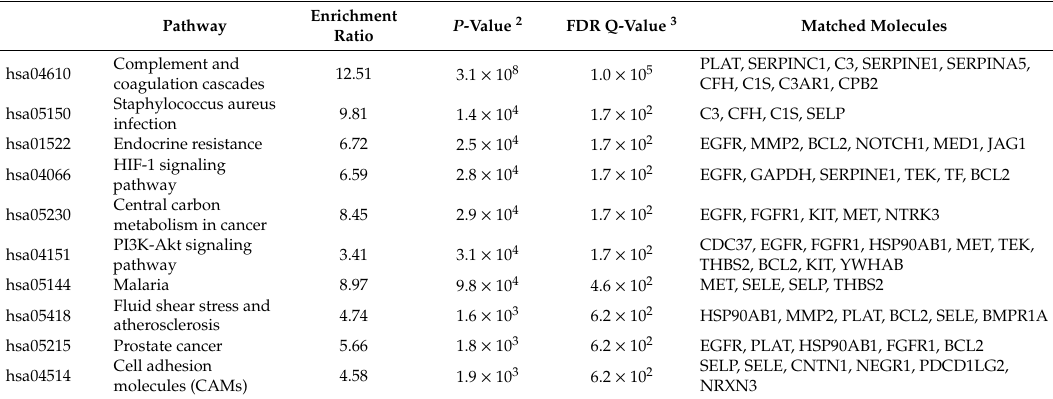
Table 4. Pathway over representation analysis of protein markers associated with dietary pattern 1.